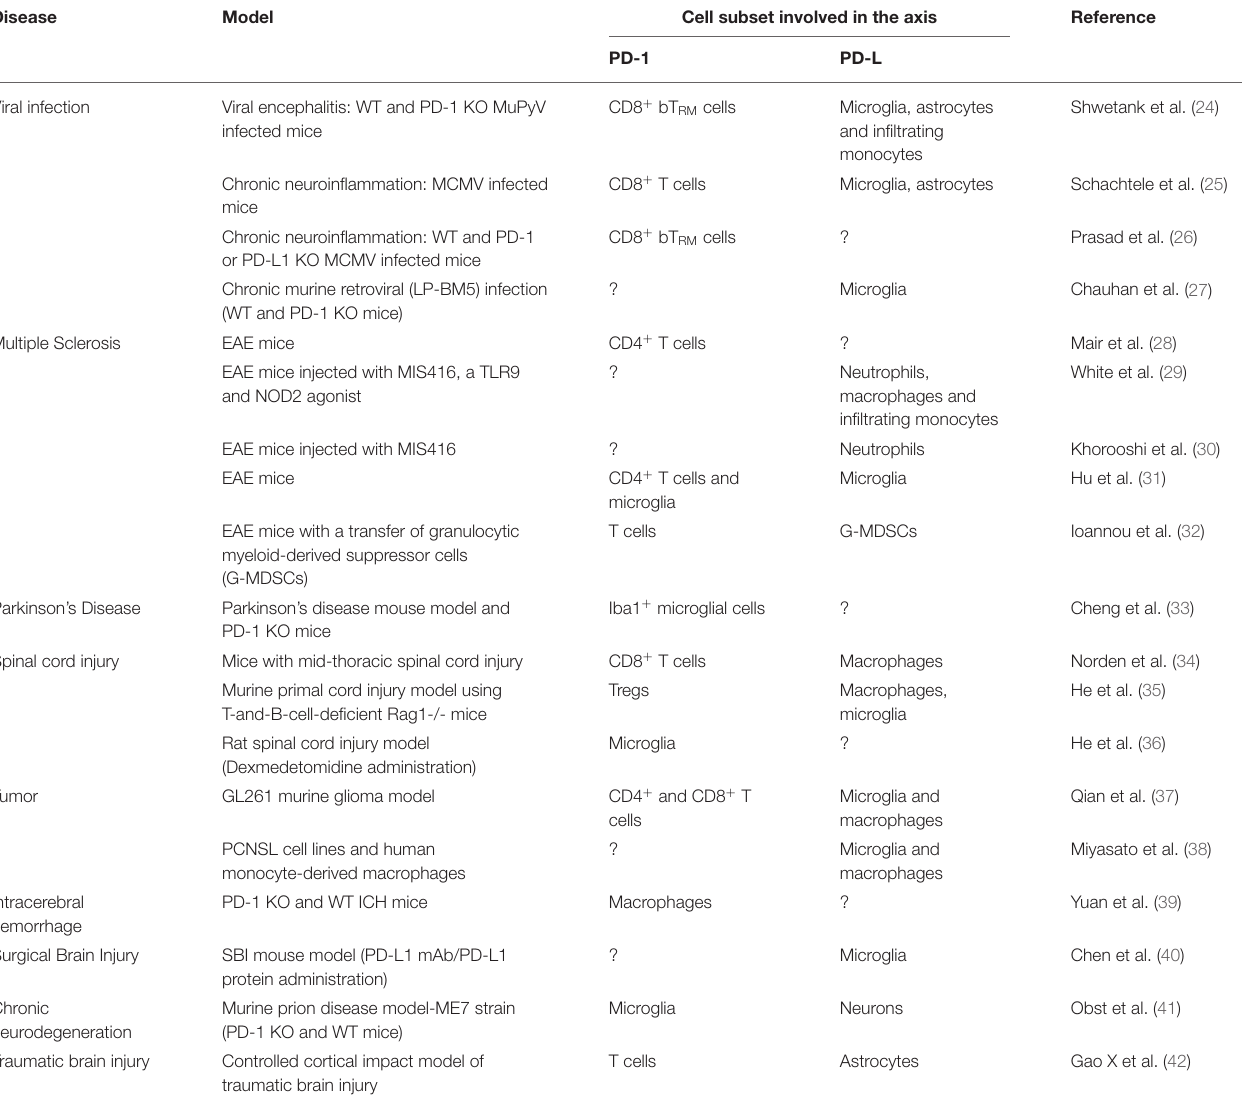
TABLE 1 | PD-1 and its ligands in animal models of neurological disorders.